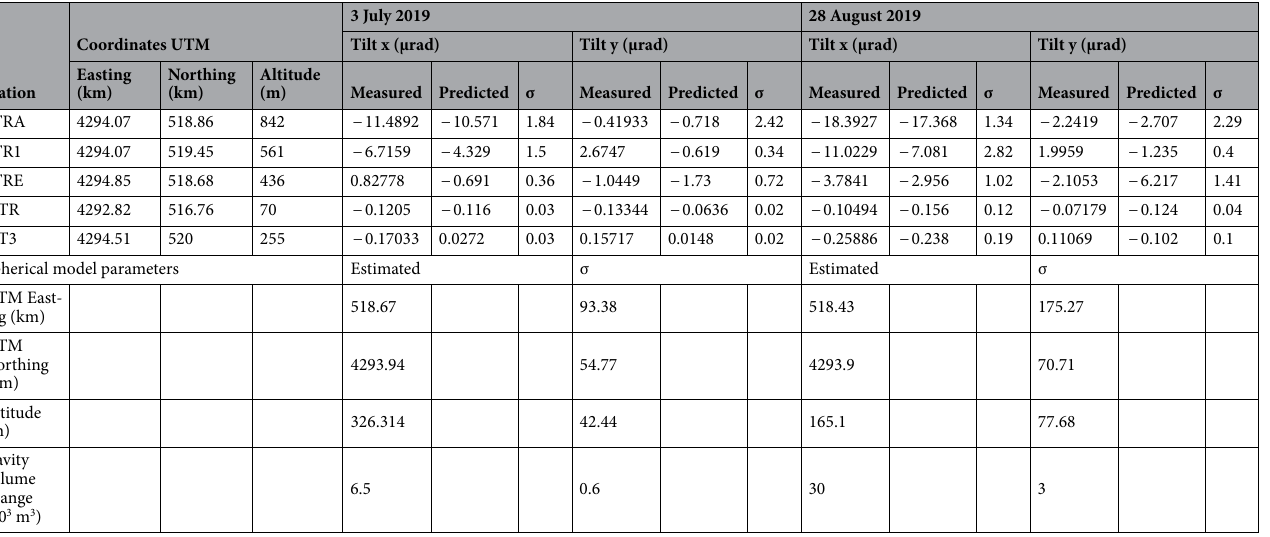
Table 1. Results from finite element (FE) modeling for the two paroxysms. The upper part reports the measured tilt components for the considered stations together with those predicted by the models and their calculated uncertainties (σ). The estimated parameters of a spherical source model and their uncertainties are reported at the bottom of the table. The models were obtained by maximizing the fitting between predicted and measured tilts using a Monte Carlo